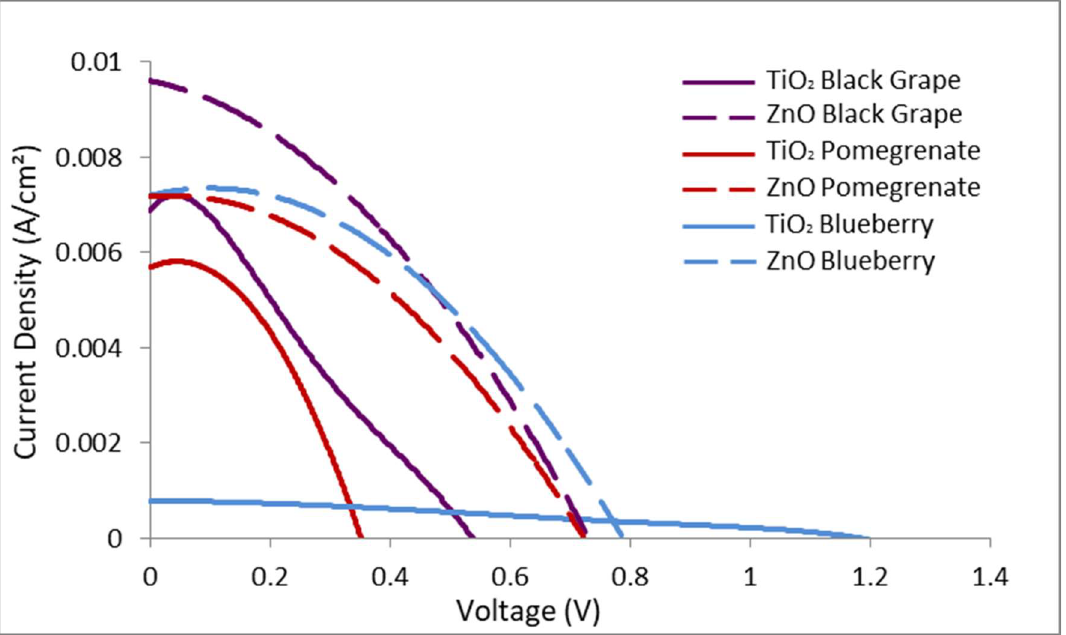
Figure 9. J–V curve for DSSCs with different types of photoanodes and dye